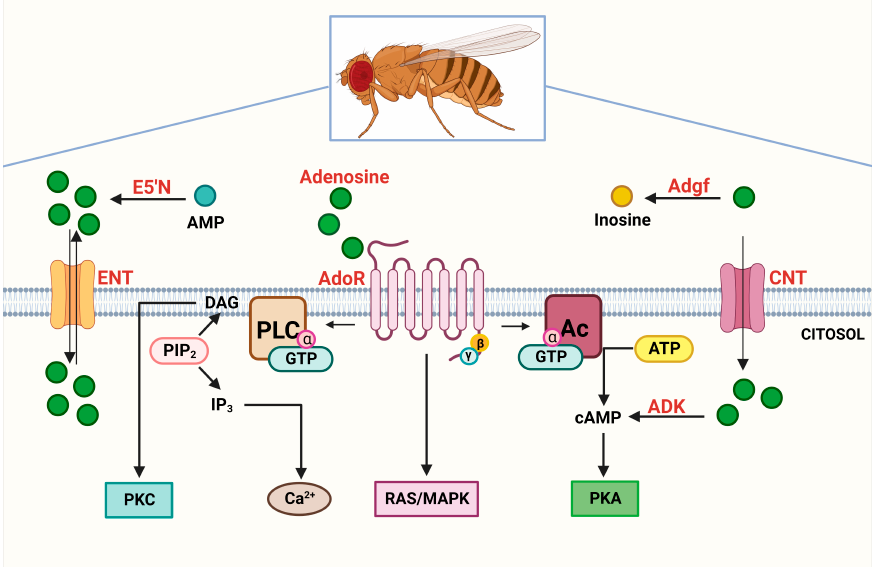
Figure 1. Adenosine signal transduction in Drosophila . AdoR: Adenosine Receptor; ENT: Equilibrative Nucleoside Transporter; CNT: Concentrative Nucleoside Transporter; e5 ′ N: ecto-5 ′‐ nucleotidase; Adgf: Adenosine Deaminase; ADK: Adenosine Kinase. Figure 1 was created with BioRender.com.